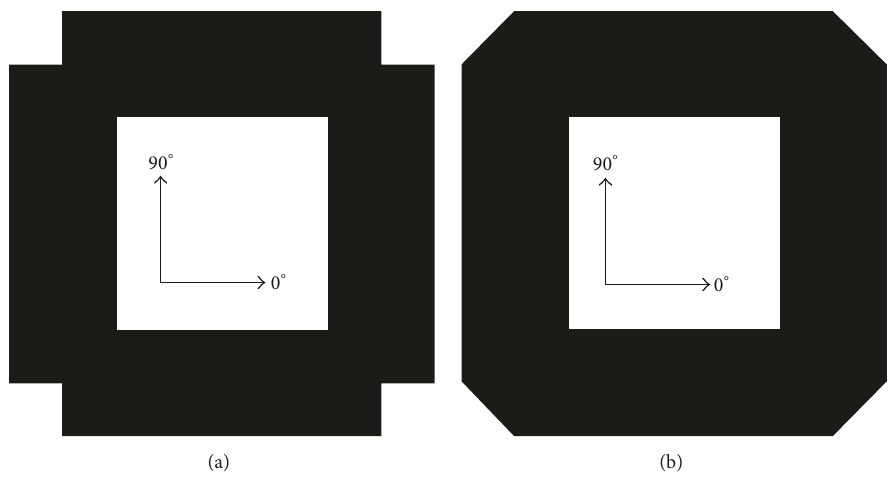
Figure 1: Ring shapes used for simulations with square (a) and diagonal corner cuts